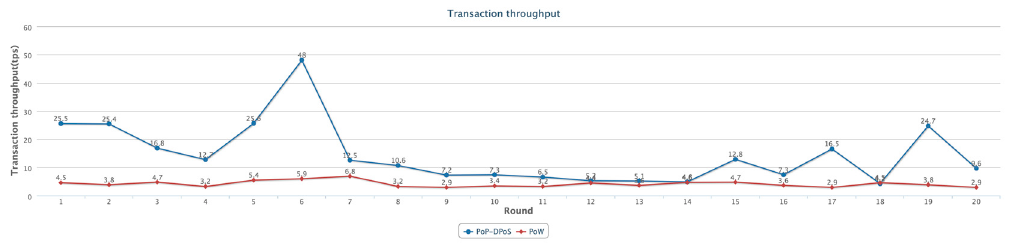
Figure 8. Transaction throughput.